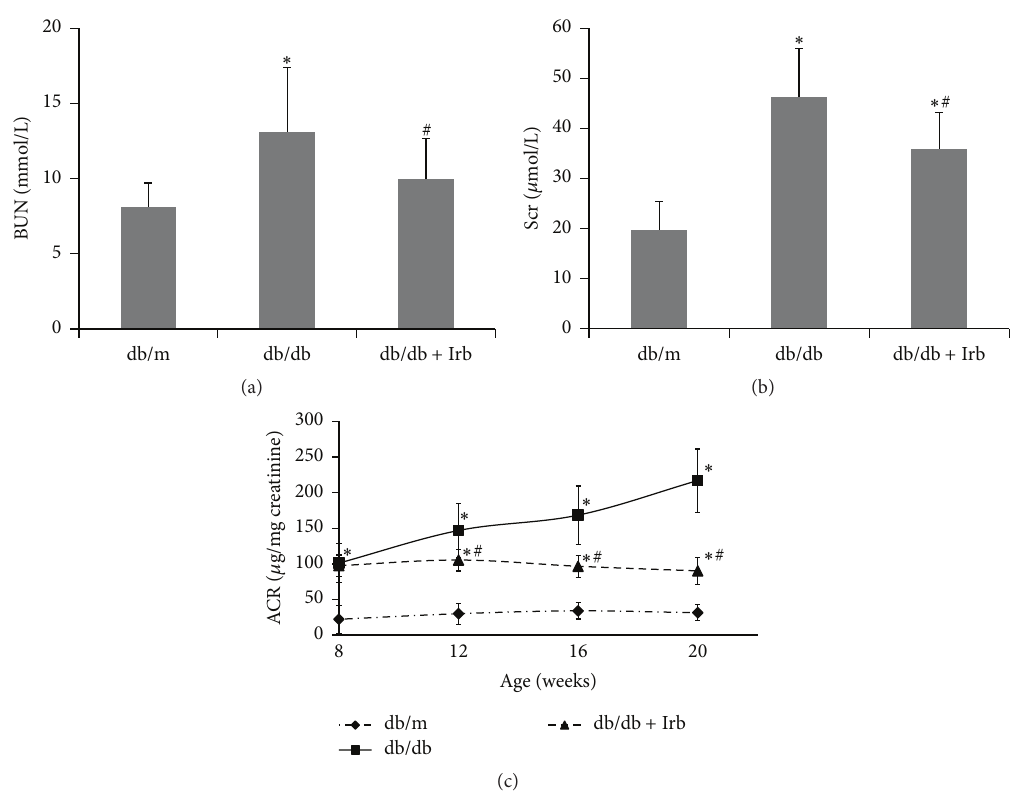
Figure 1: Irb alleviated diabetes-induced renal dysfunction. (a) BUN was increased in db/db mice and reversed significantly by Irb. (b) Scr was increased in db/db mice and reversed significantly by Irb. (c) ACR increased dramatically in db/db mice in an age-dependent method, but this increase was reversed significantly by Irb. The bars in panel (a–c) show the mean expression level in arbitrary units (error bars, S.D.). ∗ 𝑃 < 0.05 compared with db/m; # 𝑃 < 0.05 compared with db/db, 𝑡 -test.